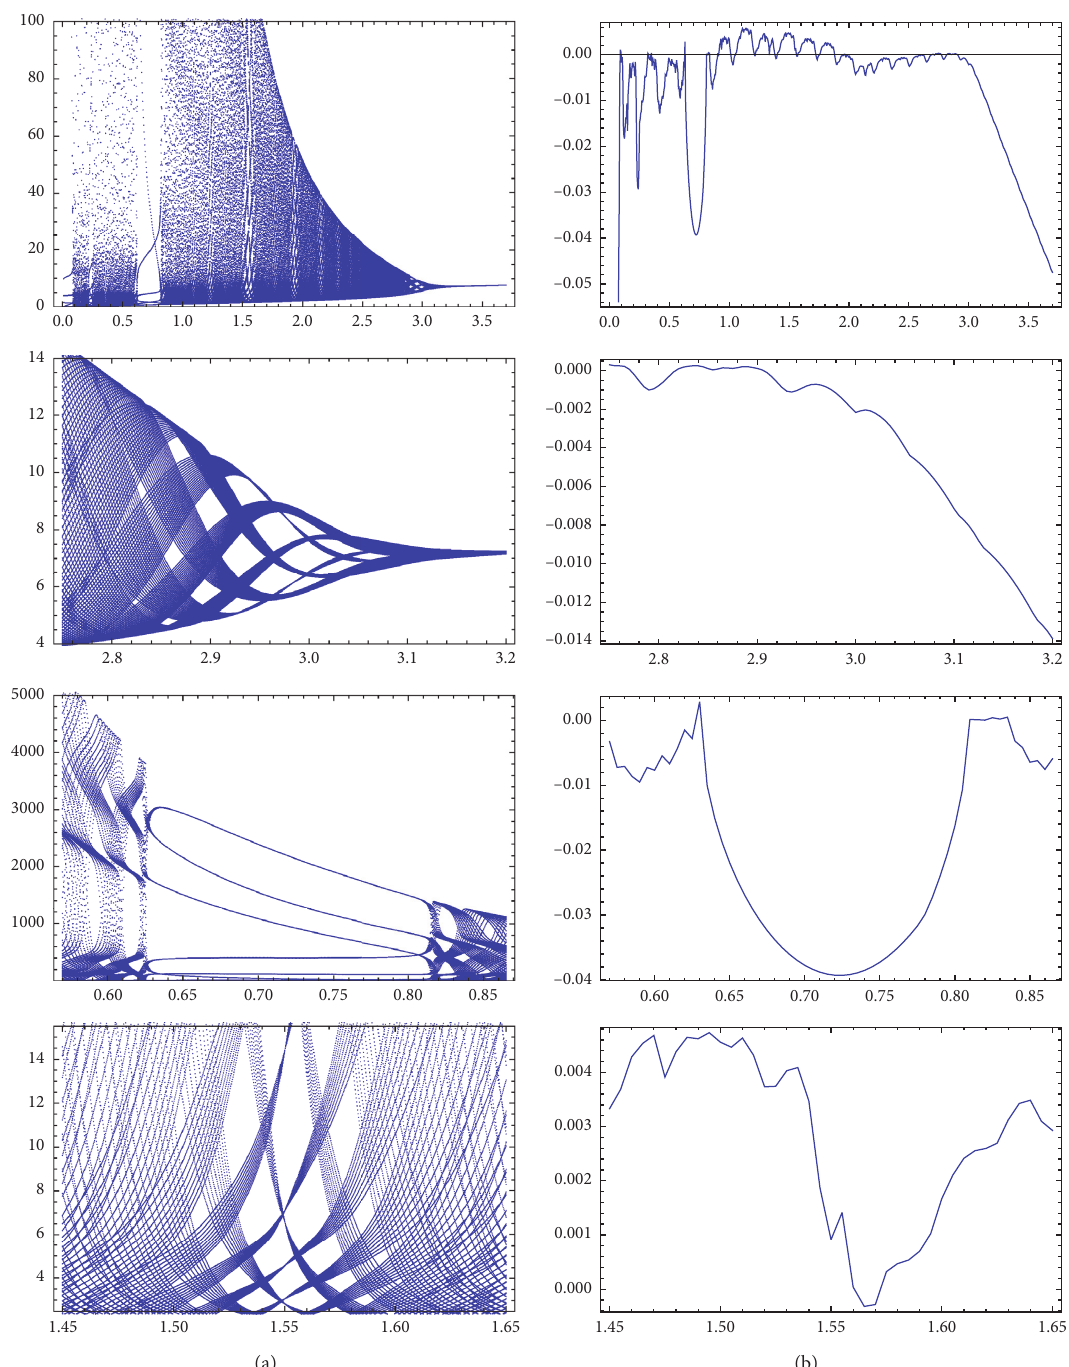
Figure 5: Bifurcation diagrams in ( p,x ) plane (a) and corresponding Lyapunov exponent (b) for values of parameter q �